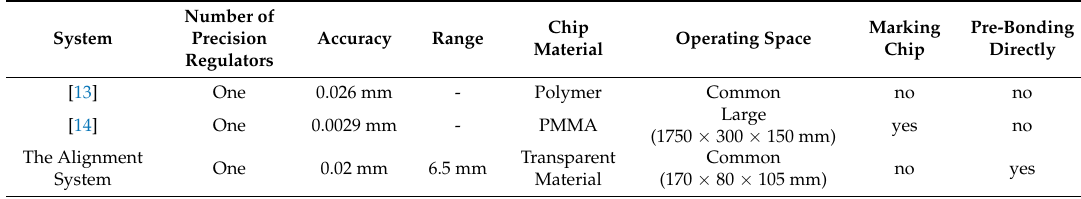
Table 1. Parameters comparison of different systems.